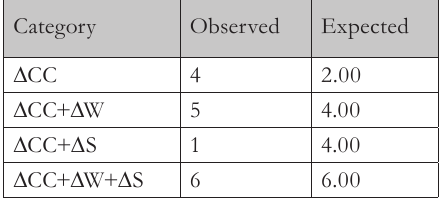
Tab. 2 – Pilot parameters of chi-square test hypothesis H1. Source: own research